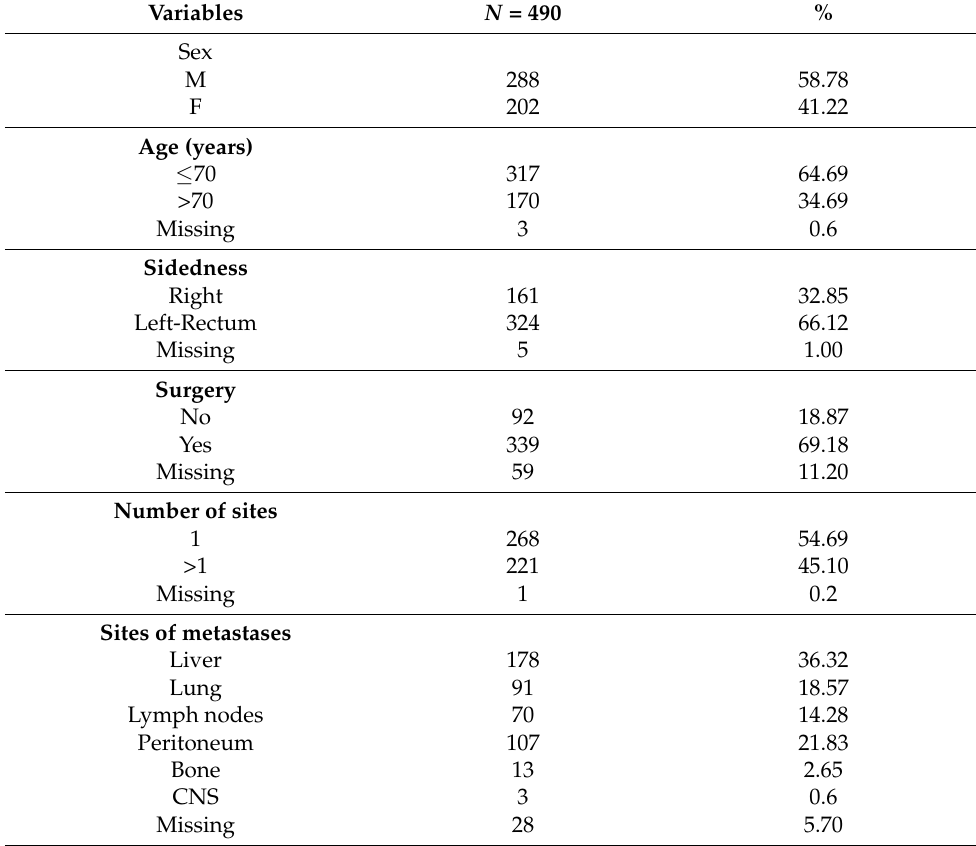
Table 1. Patient’s